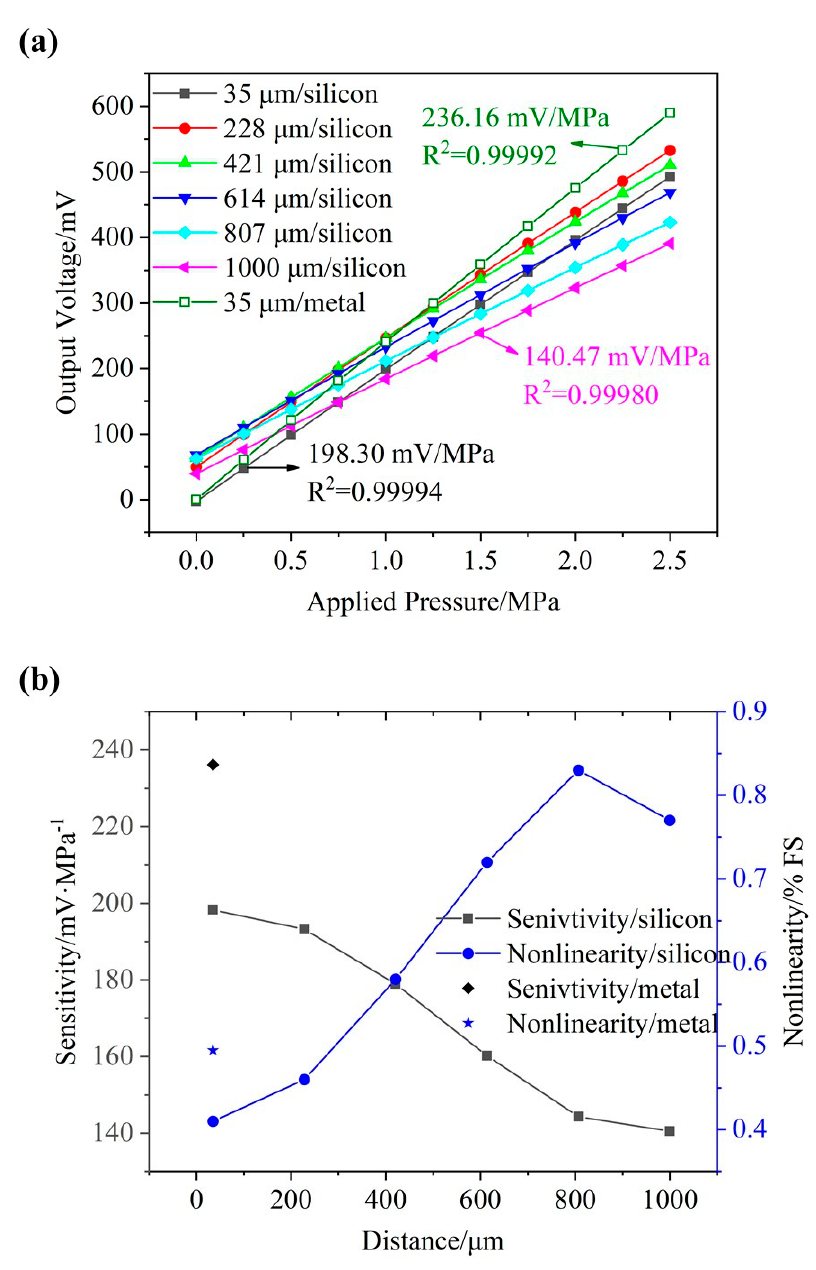
Figure 3. ( a ) The voltage output of the piezoresistive pressure sensor as a function of the applied pressure when the piezoresistors on the Y-centerline of the pressure-sensitive diaphragm were positioned at different distances from the center, with corresponding sensitivities and linearities ( b ).